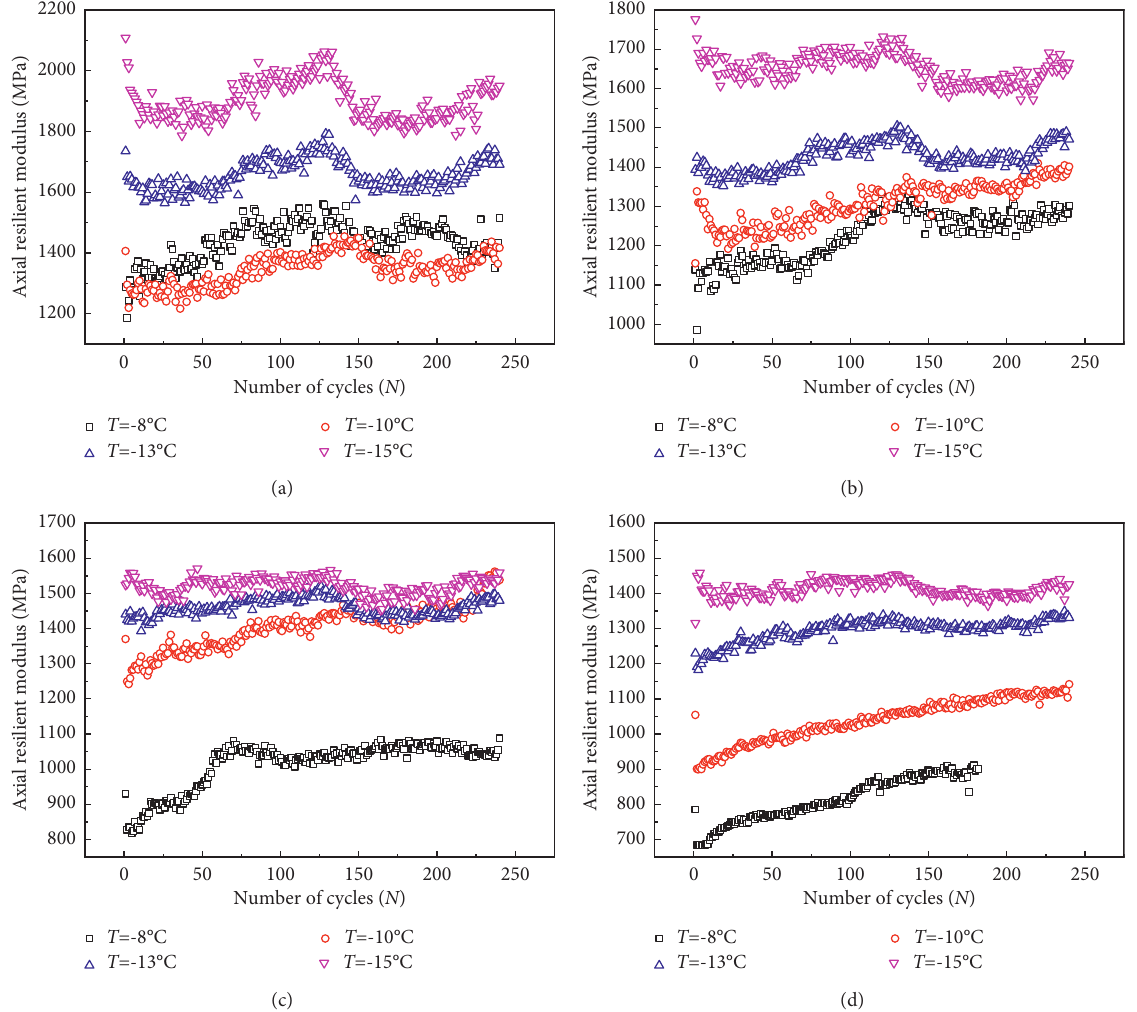
Figure 11: The evolution of the axial resilient modulus versus the number of cycles at different temperatures and CSRs. (a) CSR � 0.225. (b) CSR � 0.300. (c) CSR � 0.375. (d) CSR �